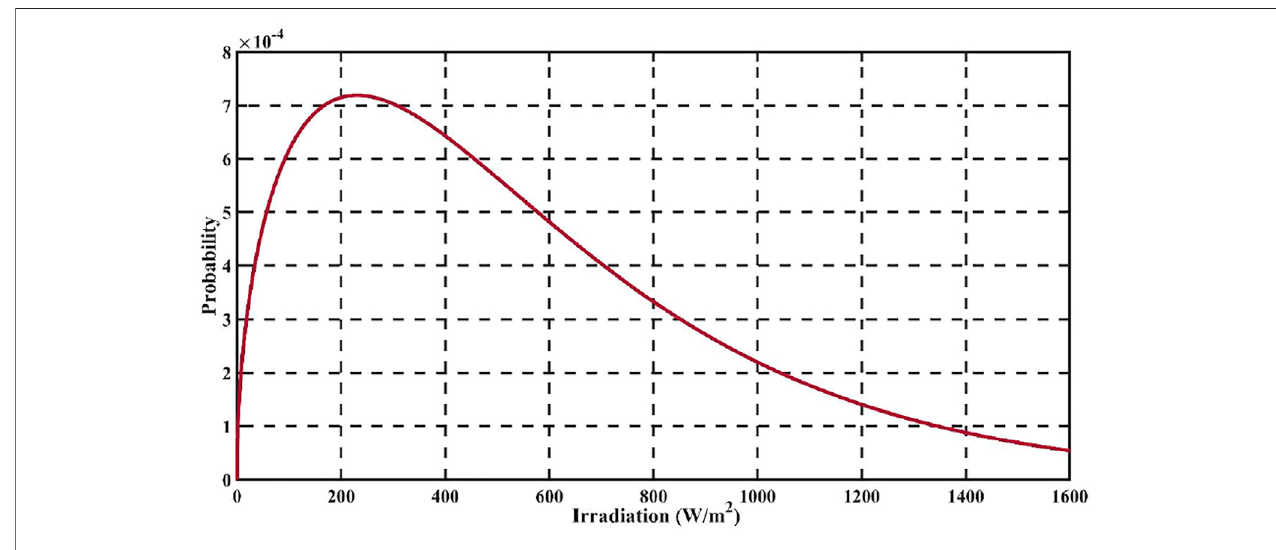
FIGURE 2 | Combined solar irradiation PDF for two farms.